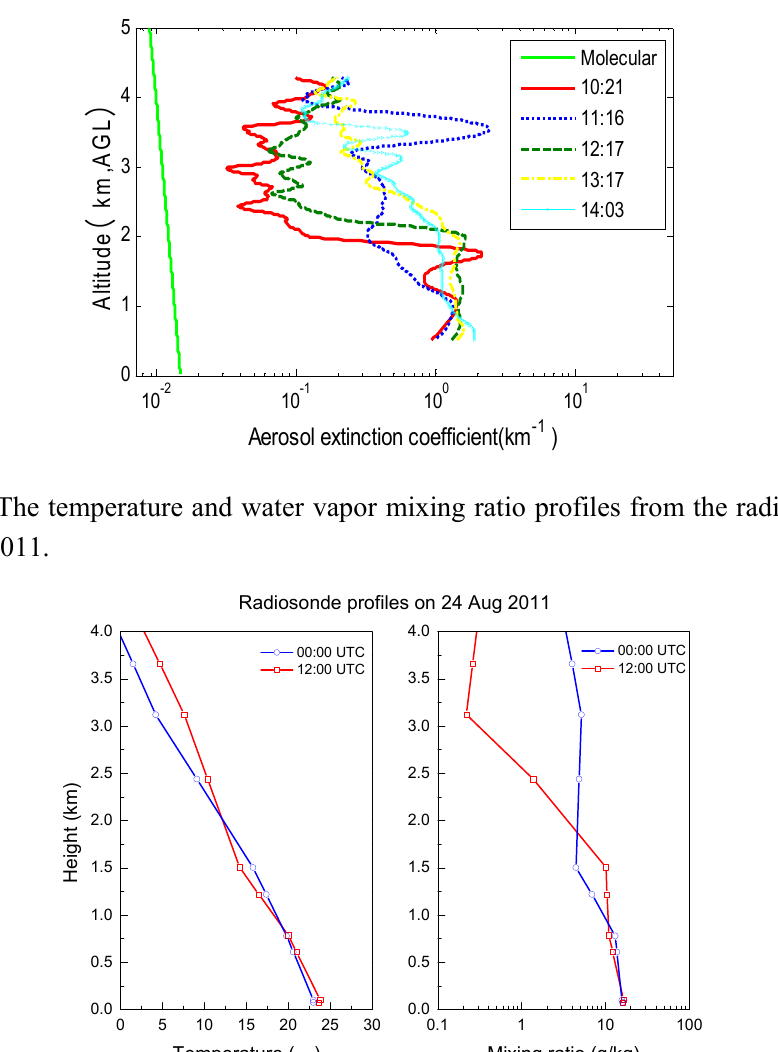
Figure 14. The extinction coefficient profiles on 24 August 2011 (data logged in LST).